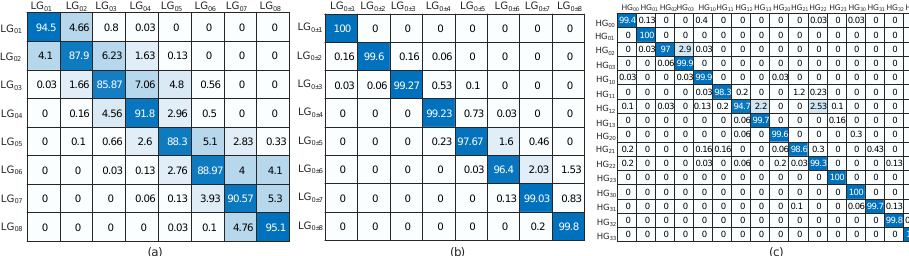
Figure 7. Confusion matrices for ( a ) 8-ary LG, ( b ) 8-ary Mux-LG, and ( c ) 16-ary at SJR of − 5